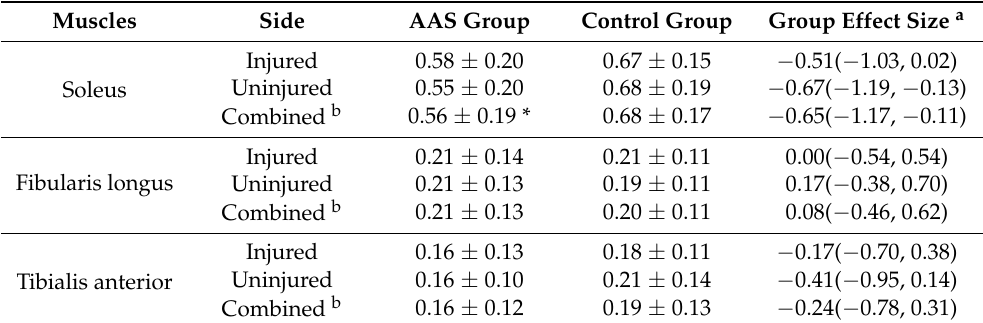
Table 2. H max /M max ratios of lower leg muscles.